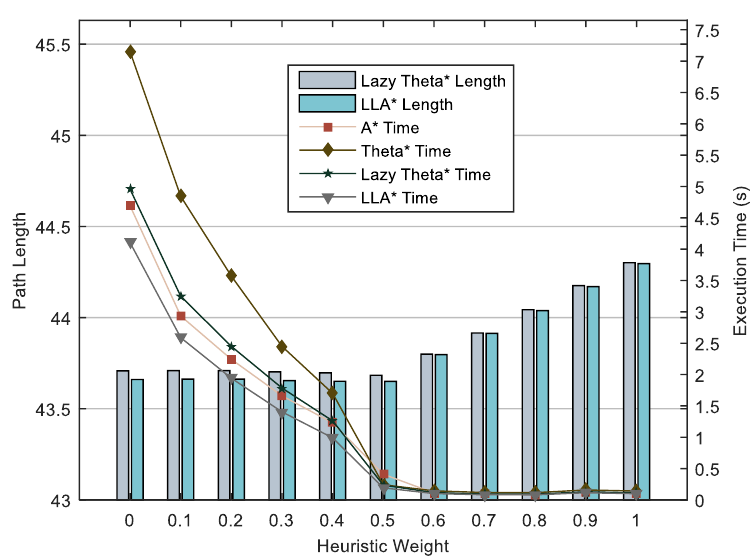
Figure 7. The average path length and execution time plotted against the heuristic weight. LLA* is the fastest, and it generates a shorter path than Lazy Theta*.